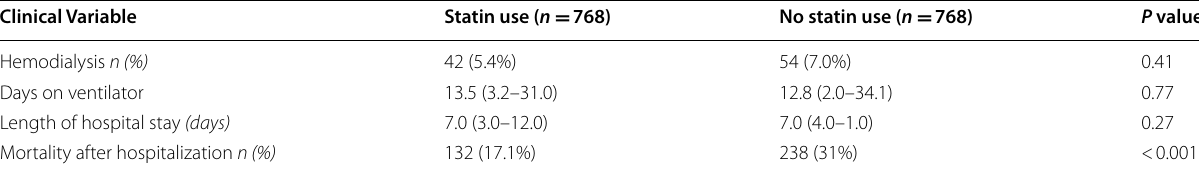
Table 3 COVID-19 hospitalized patient’s outcome and clinical interventions in matched cohort study pool